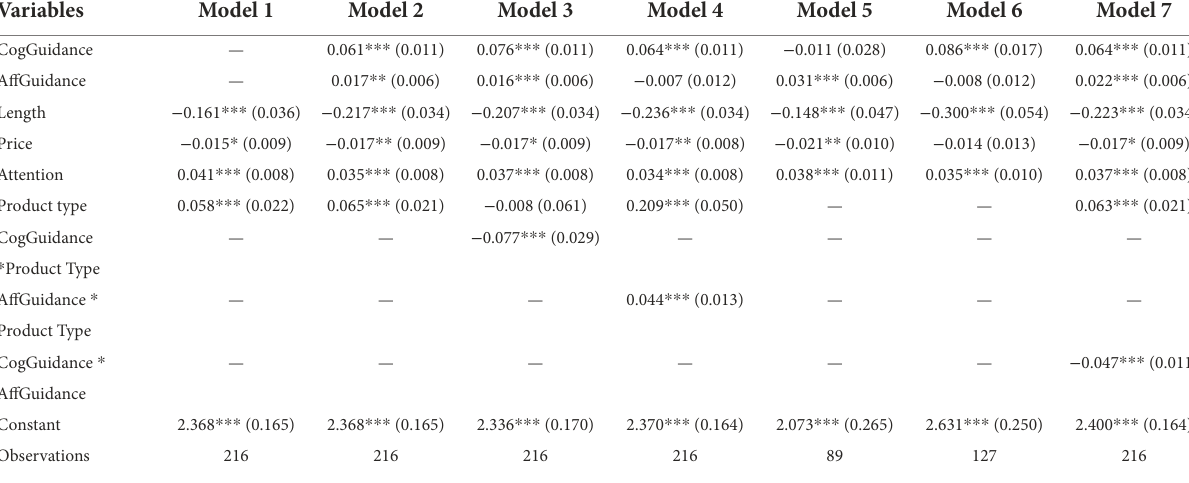
TABLE 2 Regression